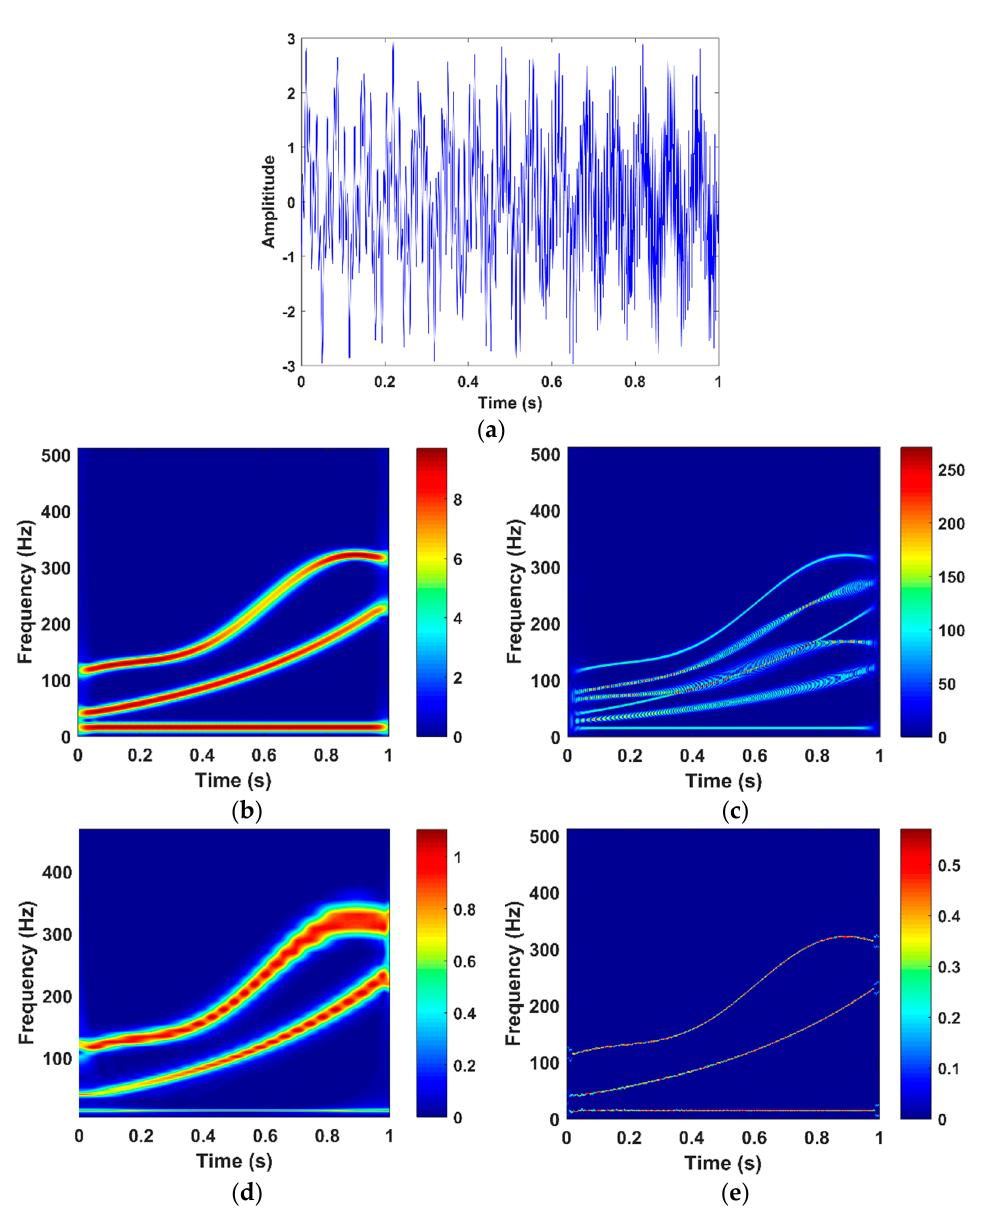
Figure 2. ( a ) Time-domain waveform of the simulated signal s ( t ) and its time–frequency images (TFIs) obtained using ( b ) short-time Fourier transform (STFT), ( c ) pseudo Wigner–Ville distribution (PWVD), ( d ) wavelet transform (WT), and ( e ) the sparse time–frequency analysis method based on the first-order primal-dual algorithm (STFA-PD).